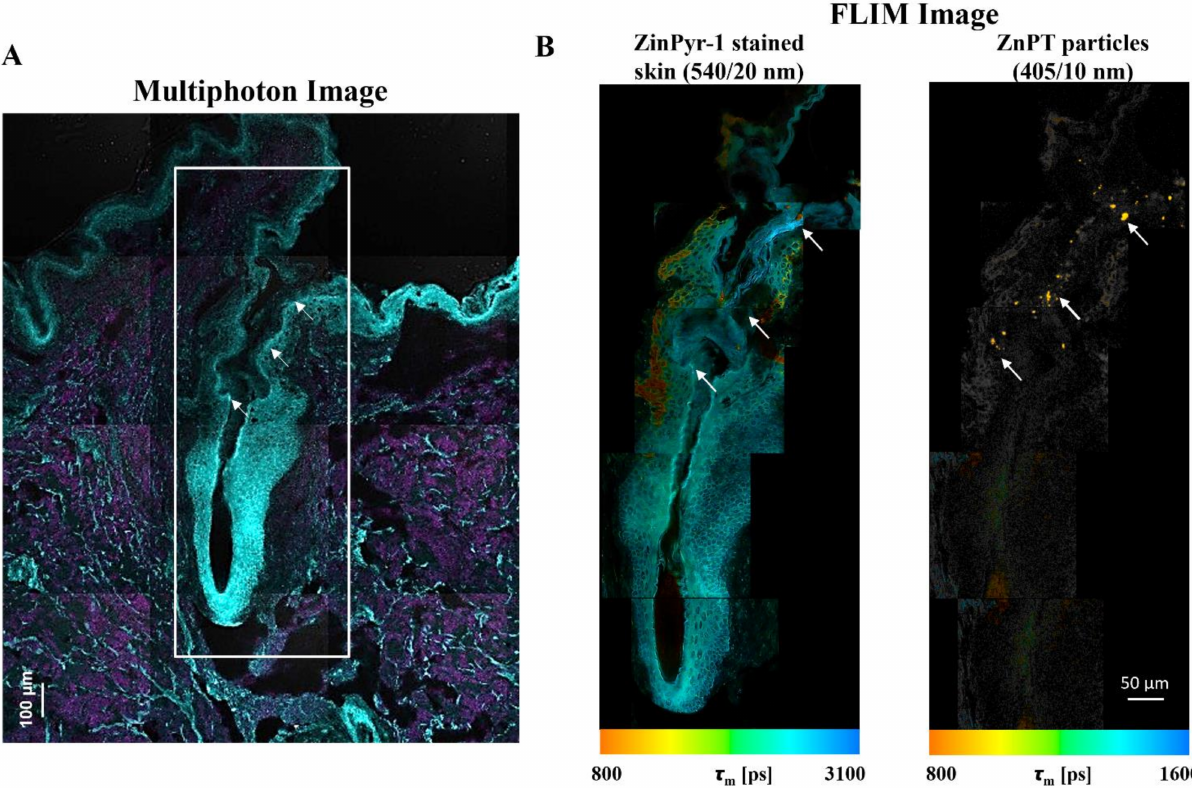
Figure 8. Fluorescence lifetime imaging microscopy (FLIM) for assessing zinc pyrithione follicular delivery to human skin. Skin was dosed with 2% w / v aqueous ZnPT suspension and cryosectioned to 20 µ m. ( A ) ZinPyr-1 stained skin imaged with multiphoton microscopy (two-photon excitation, cyan region λ ex = 800 nm, λ em = 370–420 nm; single-photon excitation, magenta region λ ex = 488 nm, λ em = 520–560 nm). ( B ) FLIM image pseudo-coloured to average time-weighted lifetime, τ [picoseconds] (two-photon excitation; λ ex = 740 nm; emission detected using two bandpass filters indicated). Arrows mark ZnPT particle